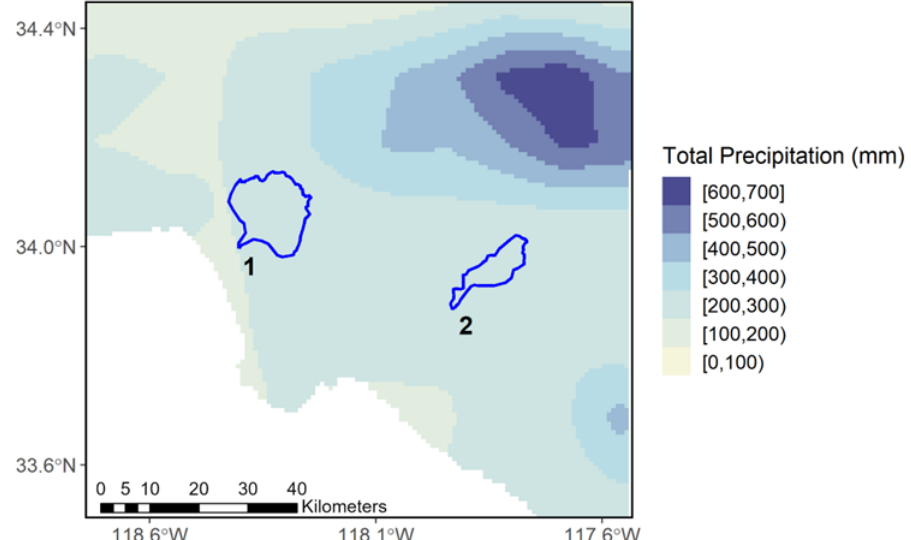
Figure 6. Total precipitation over the LA metropolitan area during the December 2010 rainfall event. The Ballona Creek (1) and the Brea Creek (2) watersheds received 232 and 266 mm of precipitation, respectively, over the 7-day event.